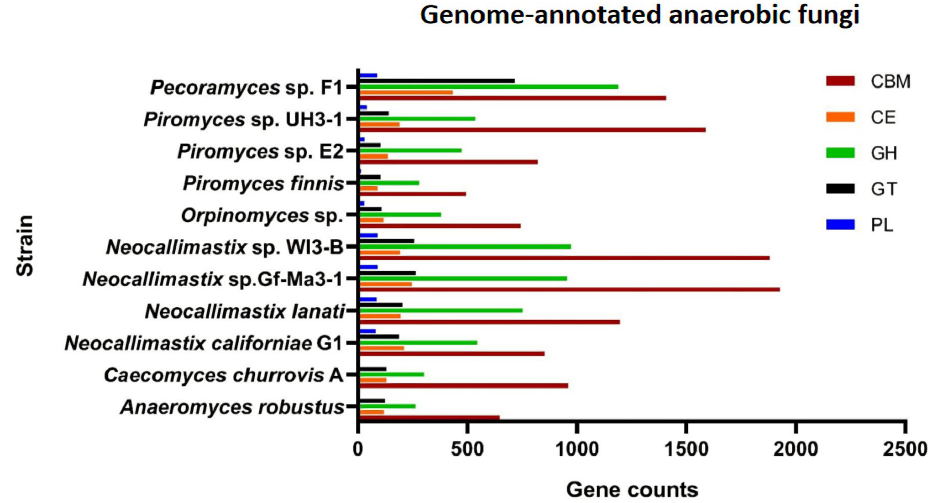
Figure 2. Genome-annotated information of anaerobic fungi. Anaerobic fungi strains that have been genome-annotated ( Caecomyces churrovis A, Anaeromyces robustus , Neocallimastix californiae G1, Neocallimastix lanati , Neocallimastix sp. Gf-Ma3-1, Neocallimastix sp. WI3-B, Orpinomyces sp., Piromyces finnis , Piromyces sp. E2, Piromyces sp. UH3-1) can be found in JGI’s MycoCosm (https://mycocosm.jgi.doe.g ov/mycocosm/annotations/browser/cazy/summary;pEimlQ?p=neocallimastigomycetes (accessed on 10 December 2021)), and the results of their annotation in the CAZymes database are included. The genome of Pecoramyces sp. F1 was uploaded to dbCAN2 [49] for online annotation, and at the same time, BLAST [50] was used for the annotation of gene models against CAZymes database too. The data of AAs presented in the annotation results of Pecoramyces sp. F1 but that of other 10 strains cannot be found in JGI’s MycoCosm (https://mycocosm.jgi.doe.gov/mycocosm/annotations/br owser/cazy/summary;pEimlQ?p=neocallimastigomycetes (accessed on 10 December 2021)), so the data of AAs are not shown. dbCAN2 and BLAST results were combined to get the Pecoramyces sp. F1 genome annotation results in the